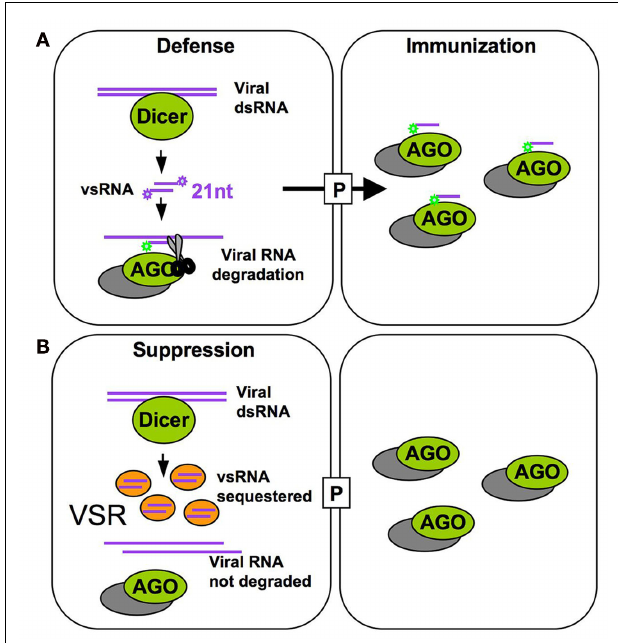
FIGURE 1 | Host antiviral defense andTMV counter defense. (A) The 21nt vsRNAs generated by Dicer processing (primarily DCL4) of double-stranded viral RNA associate with RISC to further guide vRNA degradation in the absence of theVSR. Intercellular mobility of vsRNAs allows their spreading through plasmodesmata (P) to neighboring cells ahead of the virus front and might serve to immunize naïve cells by programming RISC against the incoming virus. (B) In cells expressing the VSR, vsRNAs are sequestered and allow accumulation of viral